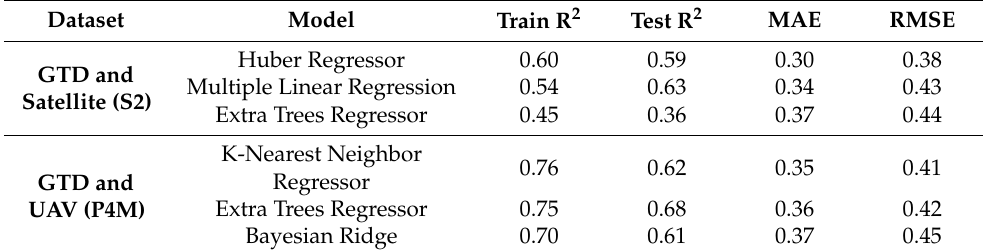
Table 7. Metrics of the best models